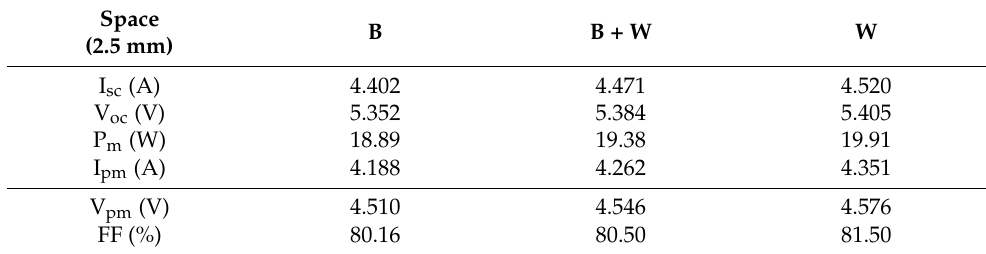
Table A3. The summary of MBB module operating test with various backsheets with 2.5 mm gap space.